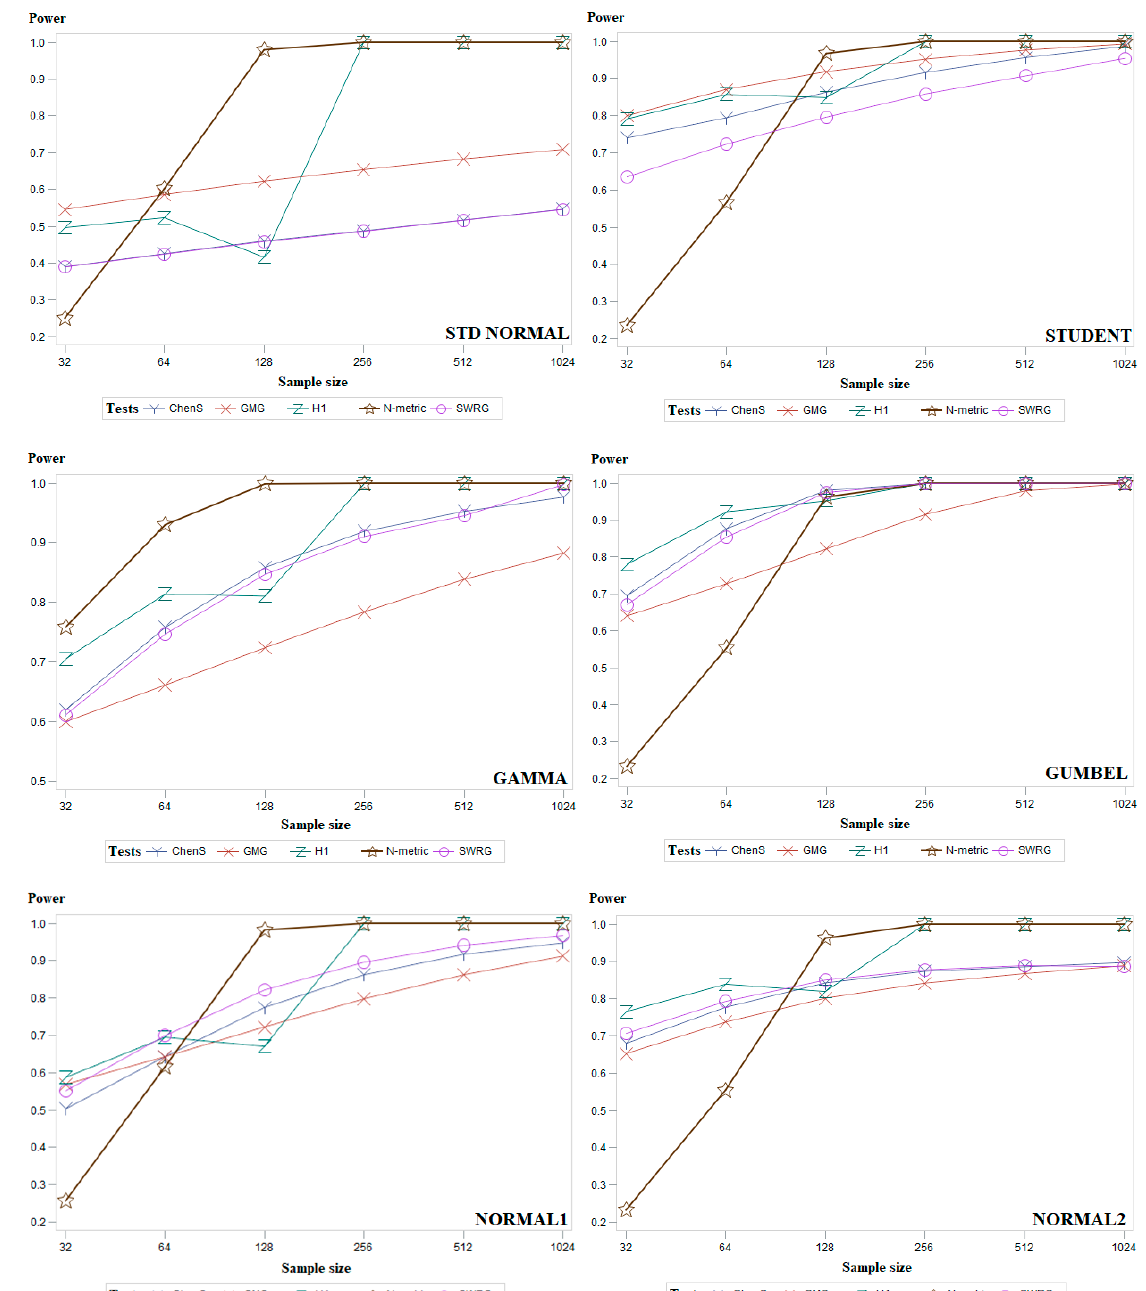
Figure 4. Average empirical power results, for the examined sample sizes, for the groups of symmetric, asymmetric, and modified normal distributions of five powerful goodness-of-fit tests.